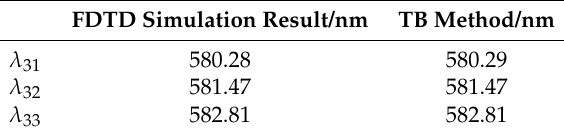
Table 1. Comparison of resonant wavelengths of optical defect modes of the CLC structure with three defect layers calculated by the FDTD-based numerical simulation and calculated analytically on the basis of the TB